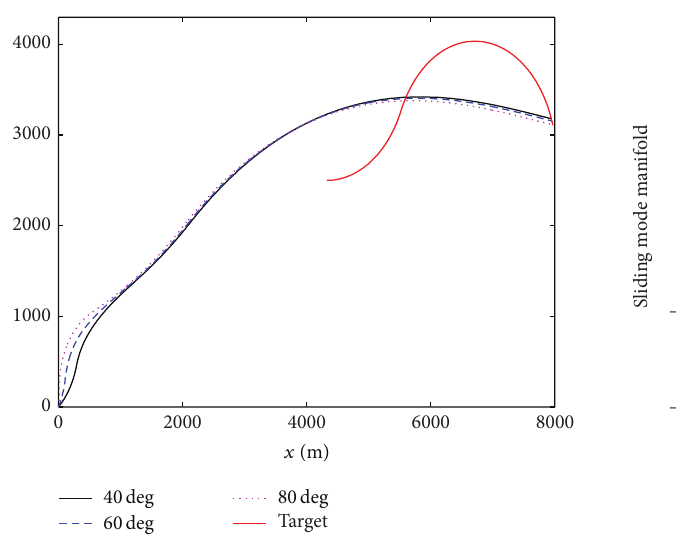
Figure 35: Sliding mode manifold.